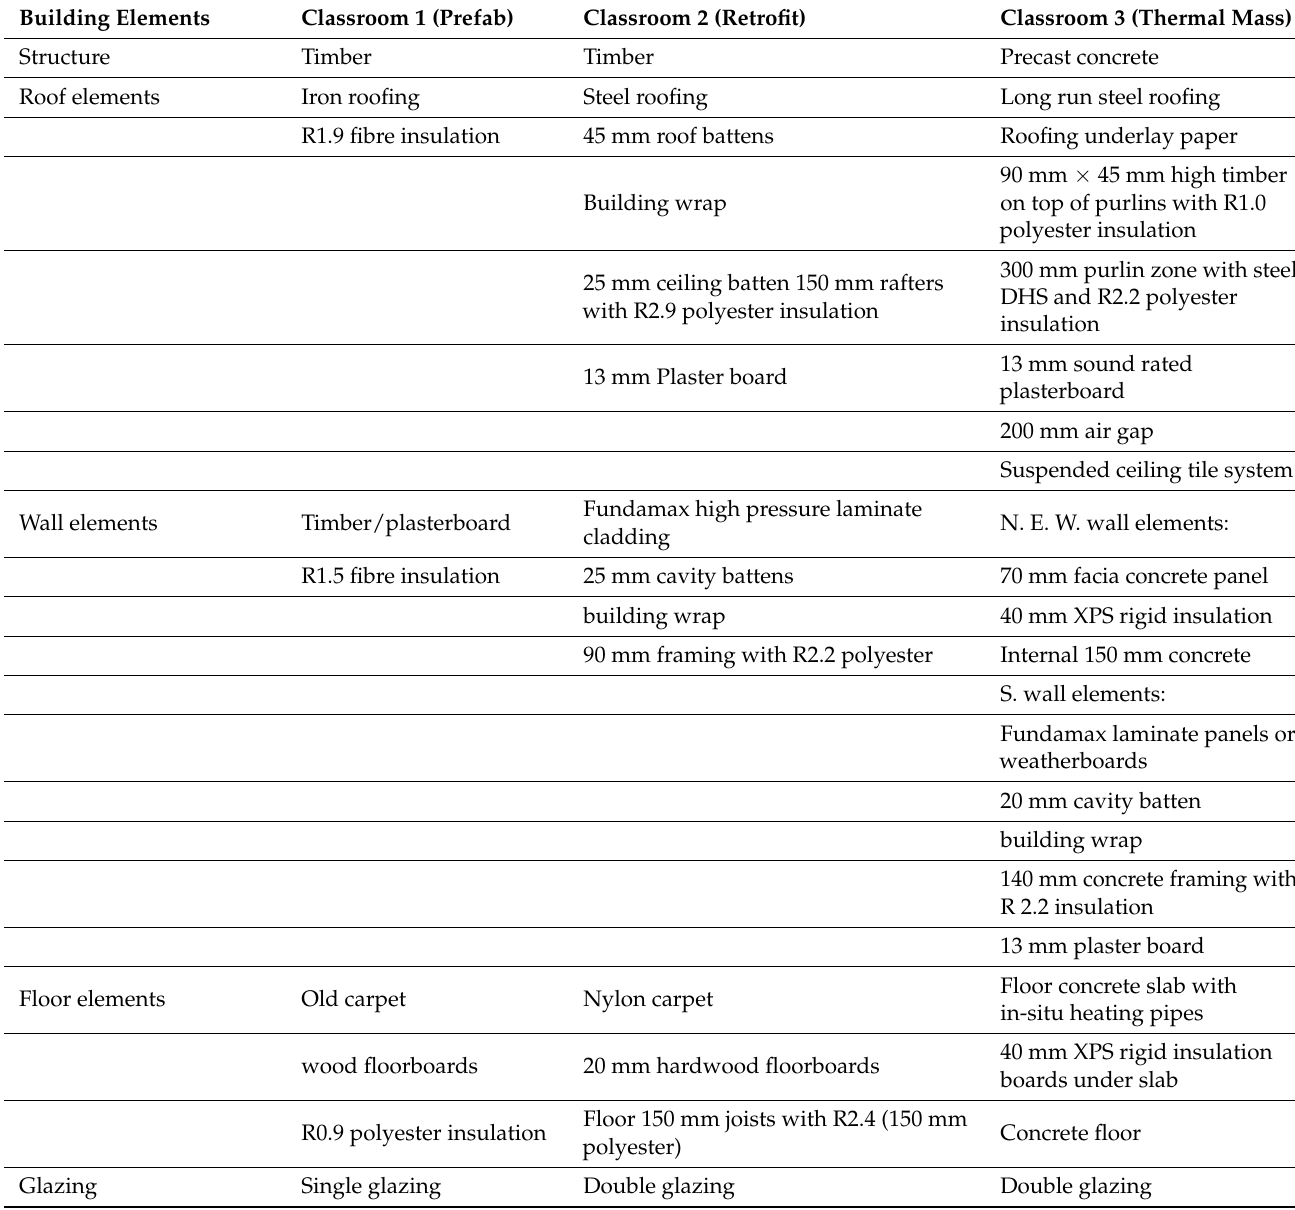
Table 1. Construction elements of the three